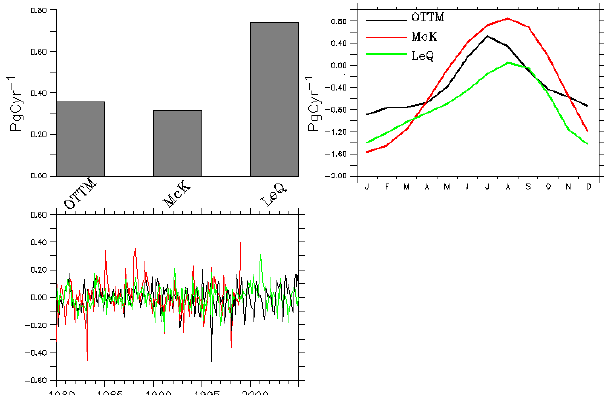
Fig. 3. The area integrated net air-to-sea CO 2 fluxes over north Pa- cific (100 ◦ E–100 ◦ W, 20 ◦ N–70 ◦ N) shown for annual mean (top- left), seasonal cycle (top-right) and interannual anomalies (bottom) Figure 3: The area integrated net air-to-sea CO 2 fluxes over north Pacific (100 0 E-100 0 W, 20 0 N-70 0 N) 8 shown for annual mean (top-left), seasonal cycle (top-right) and interannual anomalies (bottom) from 9 from three data product. The units are in PgCyr − 1 . Positive (nega- three data product. The units are in PgCyr -1 . Positive (negative) value means a source (sink) of CO 2 for 10 tive) value means a source (sink) of CO 2 for the atmosphere except the atmosphere except for the bar-diagram where positive means a net sink. 11 for the bar-diagram where positive means a net